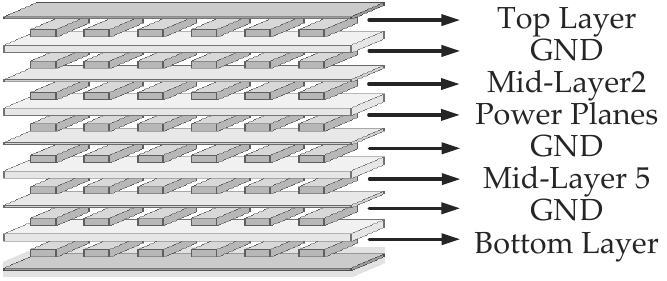
Figure 5. Stack-up of the 8 layers and signals and planes distribution of the PCB. Top and bottom layers have been routed as microstrip traces and internal layers as stripline.